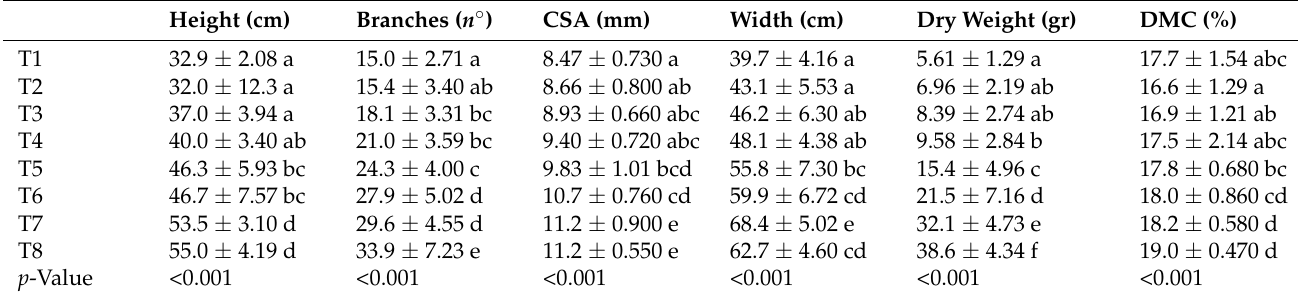
Table 2. Vegetative growth parameters of tomato plants in greenhouse pot trial with UWP treatments at the end of the trial.